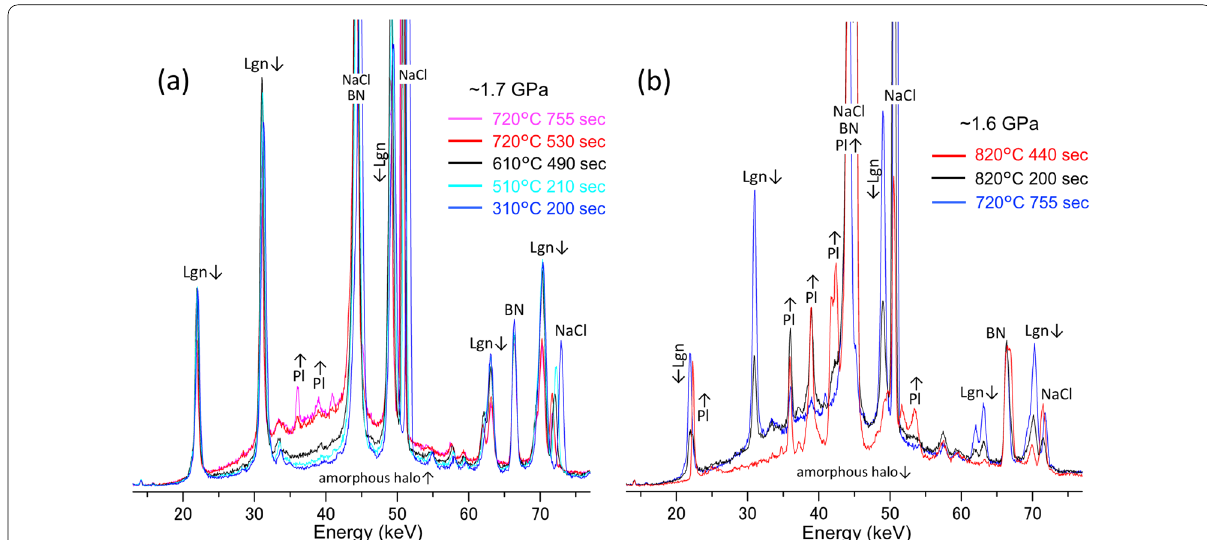
Fig. 9 Changes of XRD patterns during the back-transformation in lingunite (Run backtra12, Lgn: lingunite, Pl: plagioclase). The arrows indicate the change of the peak intensity with temperature or time. a Lingunite amorphization occurred with increasing temperature at ~ 1.7 GPa and 610–820 °C, and plagioclase crystallization started before its completion. b Crystallization of plagioclase proceeded with decreasing amorphous halo at ~ 1.6 GPa and 820